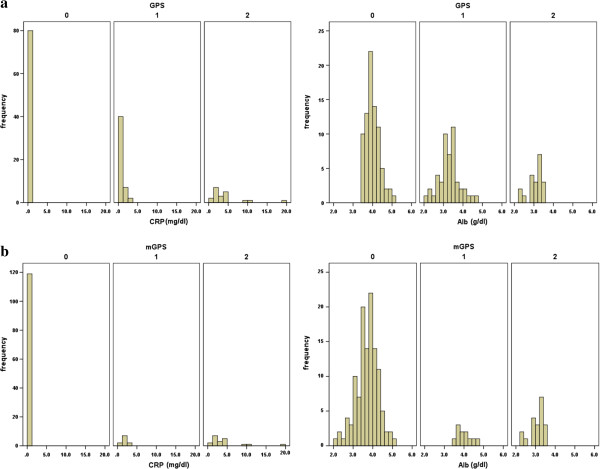
Histogram indicating the distribution of CRP and Albumin in the GPS groups (a), mGPS groups (b).